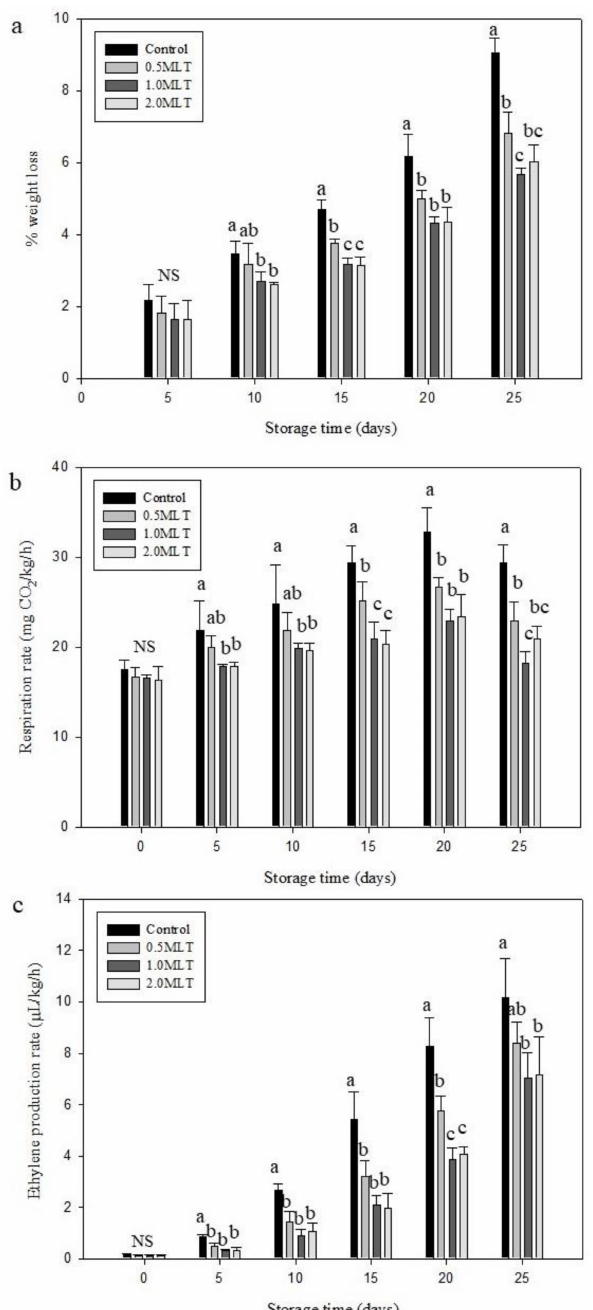
Figure 1. Effect of melatonin treatment on the percentage weight loss ( a ), respiration rate ( b ), and ethylene production rate ( c ) of green asparagus during 25 days of storage at 4 ◦ C and 90% relative humidity. Treatment in melatonin solution: 0.5 MLT (50 µ M), 1.0 MLT (100 µ M), 2.0 MLT (200 µ M); control (distilled water). Values are presented as mean ± standard deviation ( n = 3). Different letters indicate significant differences ( p < 0.05); NS = not